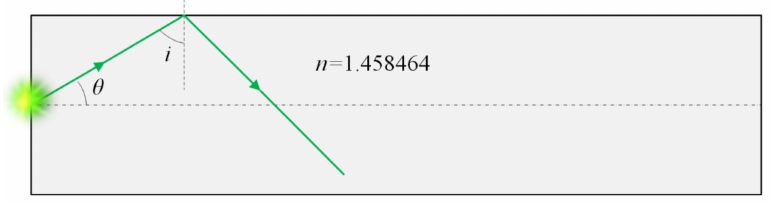
Figure 5. Schematic diagram of the total reflection in the homogenizing pipe.